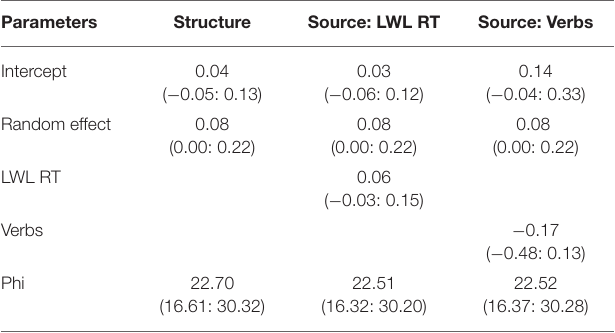
TABLE 2 | Parameter estimates for models of graded individual differences. Parameters